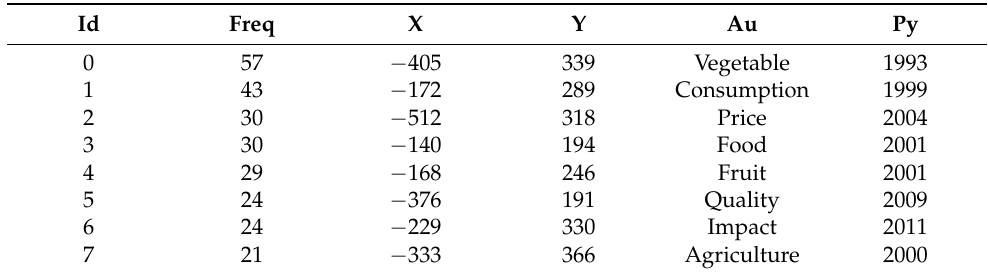
Table 3. Ranking of WOS Co-occurrence